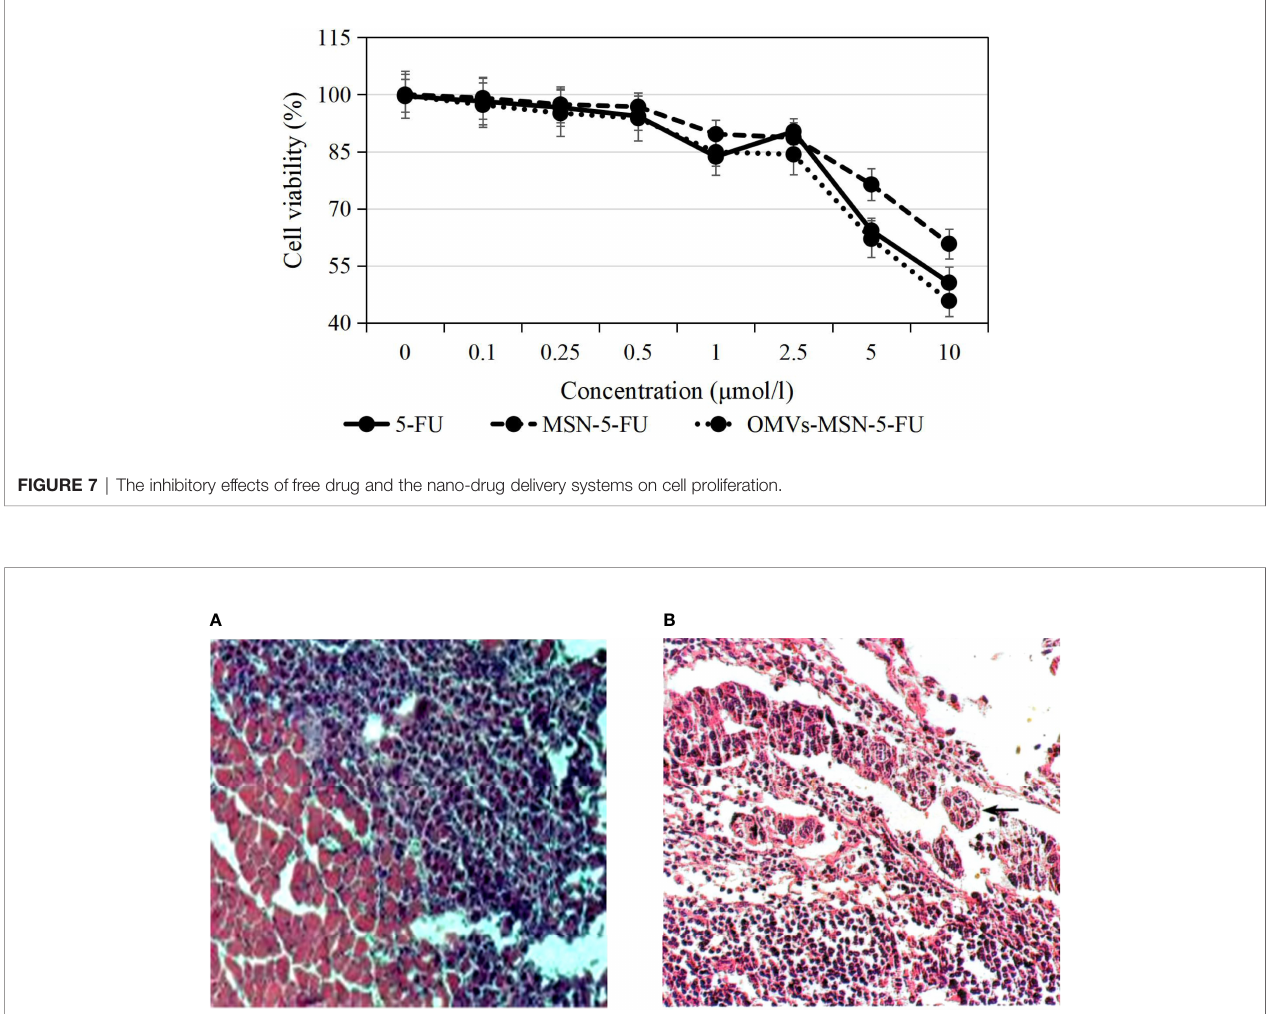
FIGURE 8 | HE staining results of tissue sections. (A) was HE staining of adjacent tissue sections (×400); (B) was HE staining of tissue sections of cervical lymph node metastases